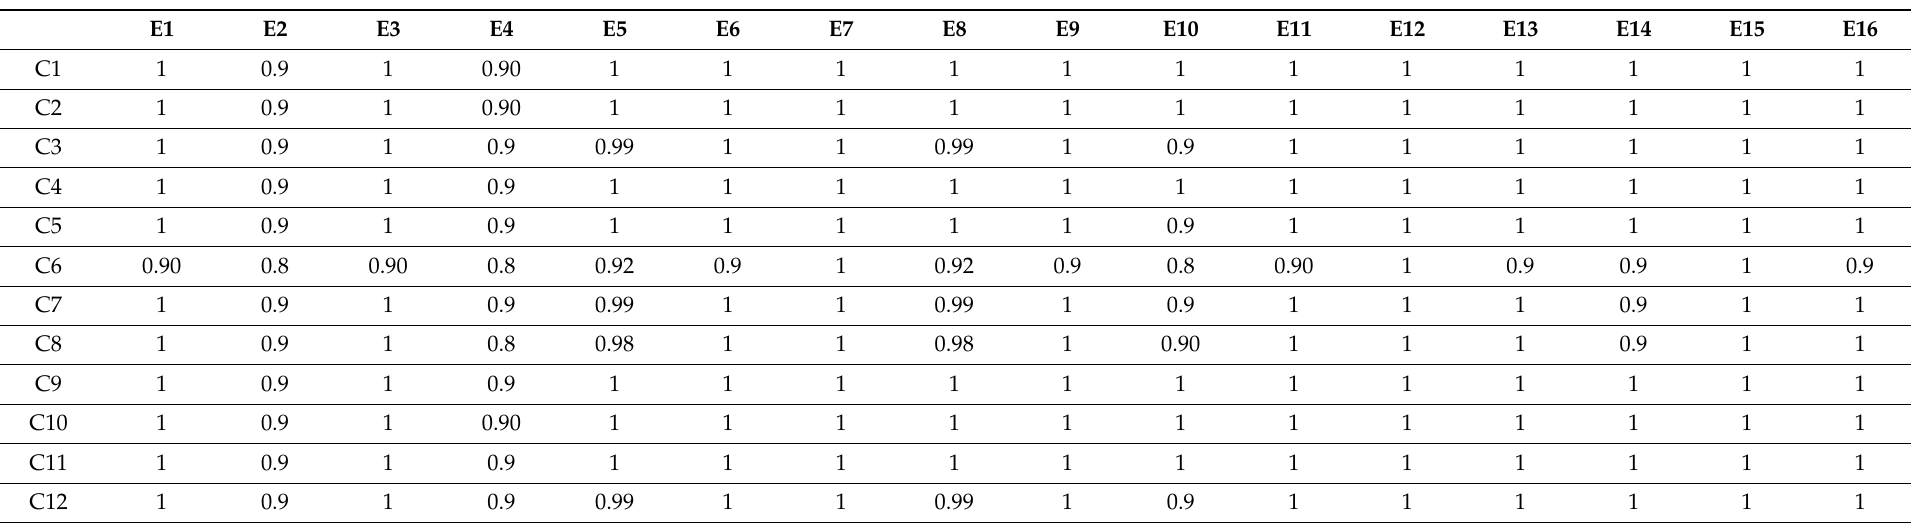
Table A2. Cause–effect matrix to conversion